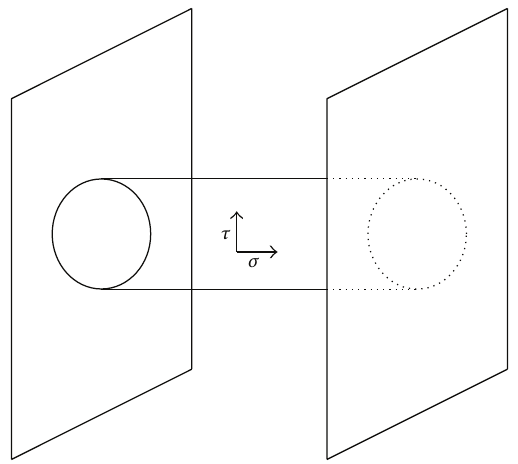
Figure 4: One-Loop String Diagram. Shown is the diagram for an open string, whose end points are fixed on two different 𝐷𝑝 - branes, propagating in a loop, 𝜏 being the time variable on the world sheet. Alternatively, interchanging 𝜏 with 𝜎 , the same diagram can be interpreted as a closed string being exchanged between the two 𝐷𝑝